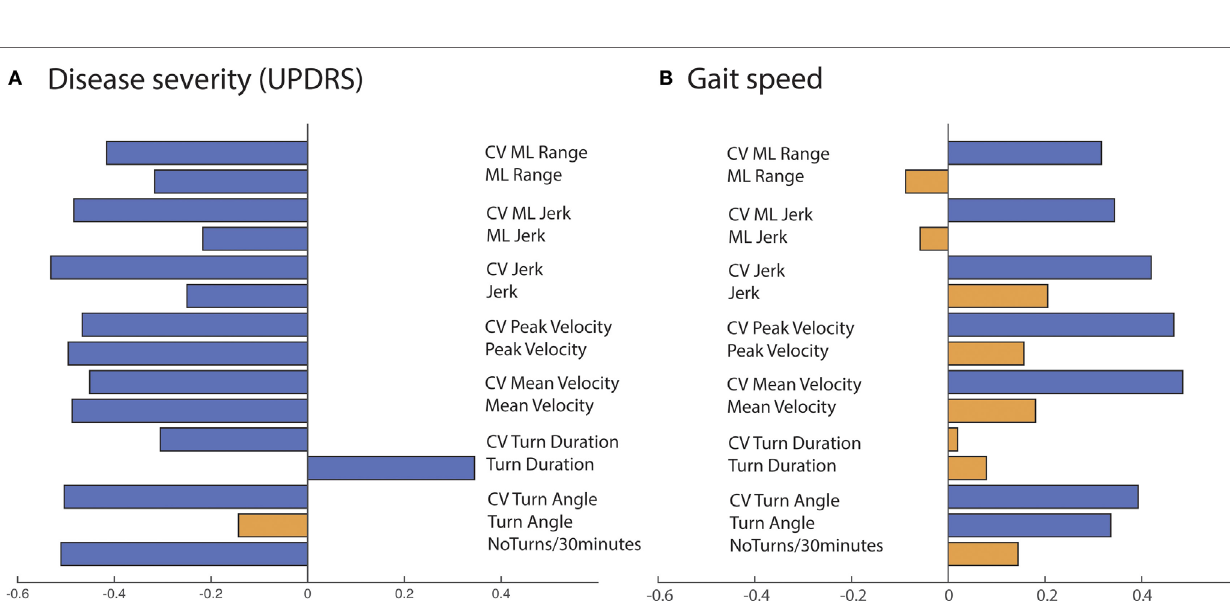
FigUre 4 | Summary of Pearson’s correlations of disease severity (a) and gait speed (B) with quantity/quality of turning over 72 h across all the Parkinson’s disease participants. Blue bar: p -value < 0.05, orange bar: p -value > 0.05.